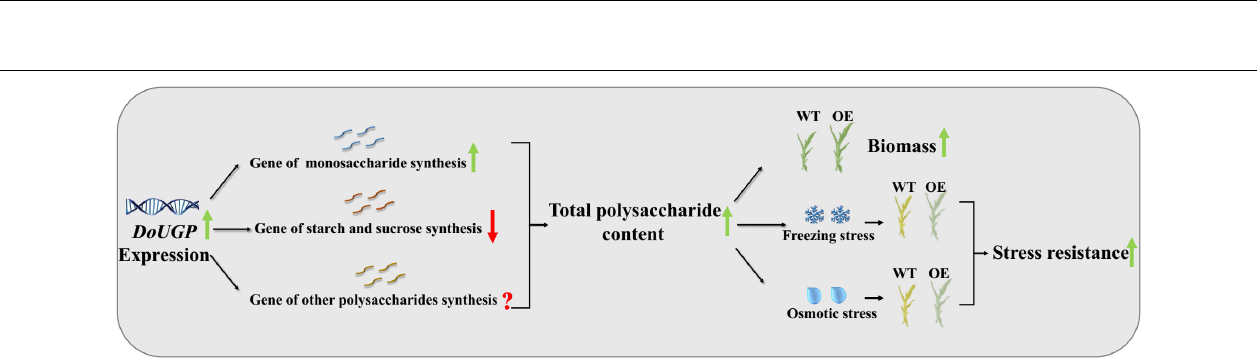
FIGURE 7 | Schematic diagram of how DoUGP overexpression enhances biomass and promotes stress resistance of D. officinale plants.